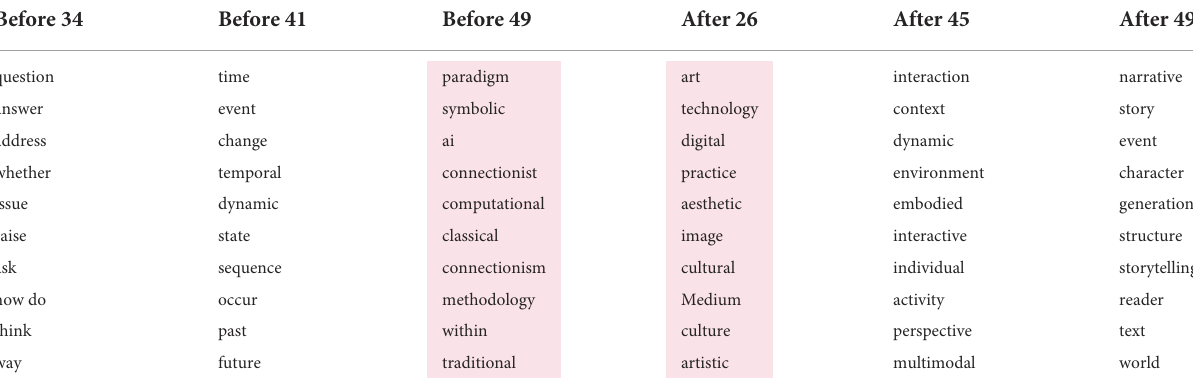
HighlightedcolumnsarediscussedascasestudiesinSection3.2. TABLE 2 Contextual information for before topic 49 (404 papers) and after topic 26 (474